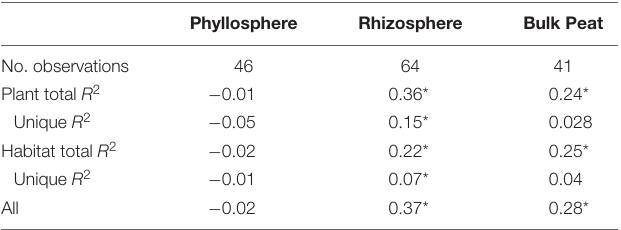
TABLE 4 | Variance partitioning of putative methanogens by compartment based on Bray–Curtis distance between communities considering each compartment (phyllosphere, rhizosphere, and bulk peat)